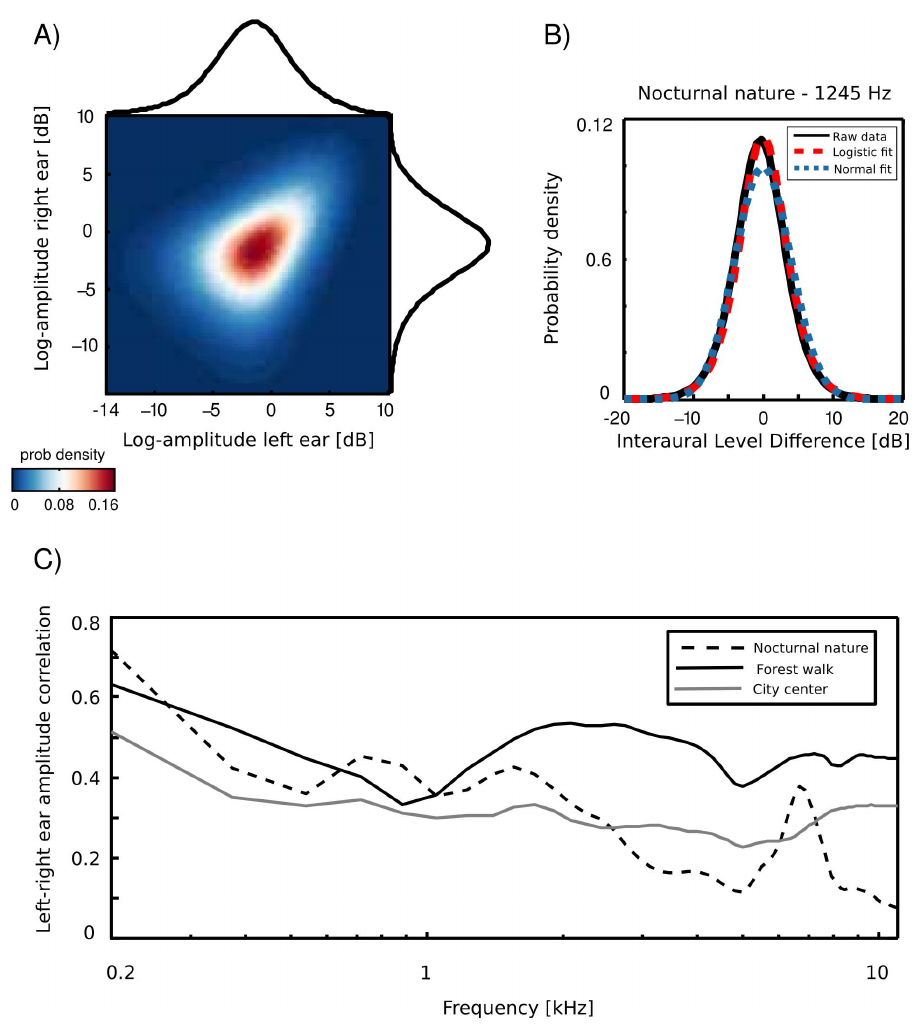
Figure 3. Binaural amplitude statistics. A) An exemplary joint distribution of monaural amplitudes at 1245 Hz. Exemplary data were taken from the nocturnal nature recording. B) An ILD distribution of the same data, plottedtoghether with a Gaussian and a logistic fit (blue and red dotted lines respectively) C) Interaural amplitude correlations across frequency channels